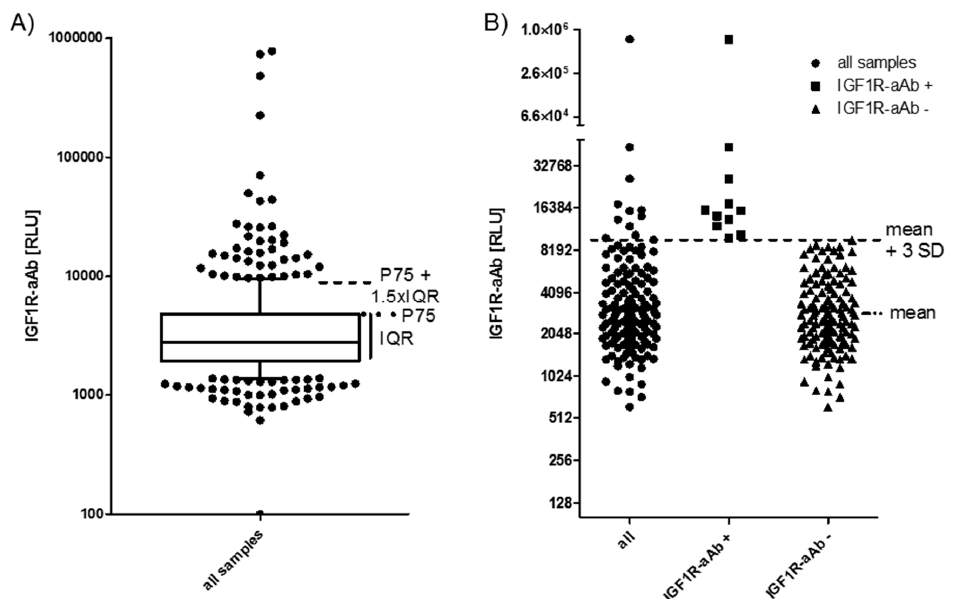
Figure 1. IGF1-Receptor autoantibodies (IGF1R-aAb) in serum of the study subjects. ( A ) Sera from the full collection of samples ( n = 408) were analyzed for IGF1R-aAb, and relative light units (RLU) were recorded. The outlier criterion of P75 plus 1.5 times the interquartile range (P75 + 1.5 × IQR) was applied to identify samples with positive IGF1R-aAb. ( B ) Analysis of the study population at time point T-3 (three months before study start). This analysis used the outlier criterion mean plus three standard deviations (mean + 3 SD). Irrespective of outlier criterion used ( A or B ), both analyses identified the same 11 out of 143 subjects as positive for natural IGF1R-aAb.